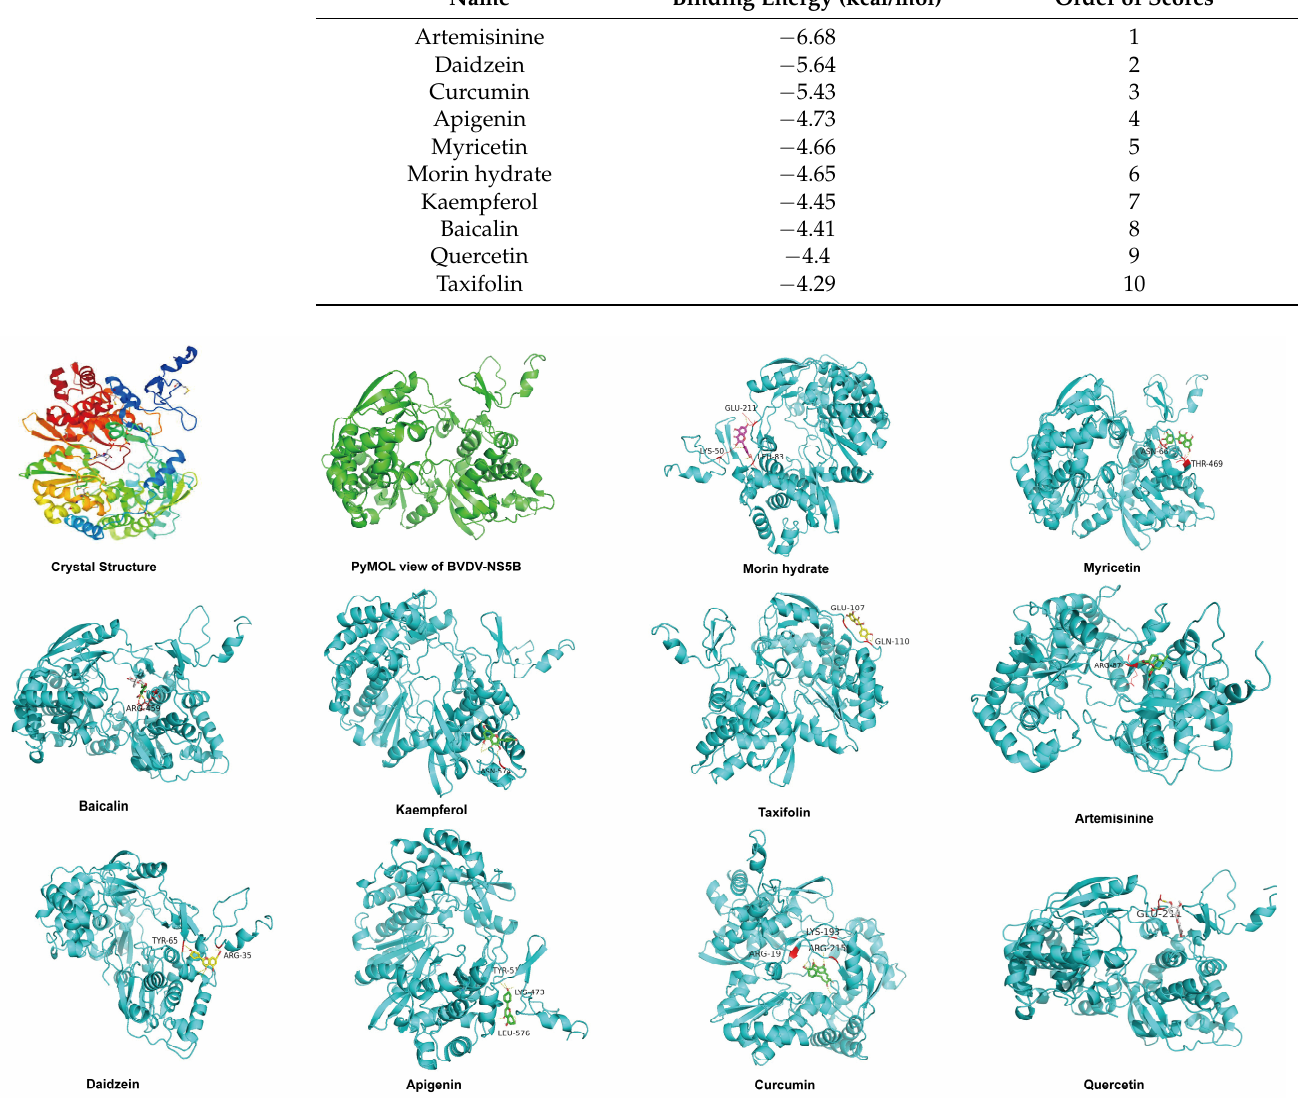
Figure 1. Molecular docking structure diagram. 颜色解释